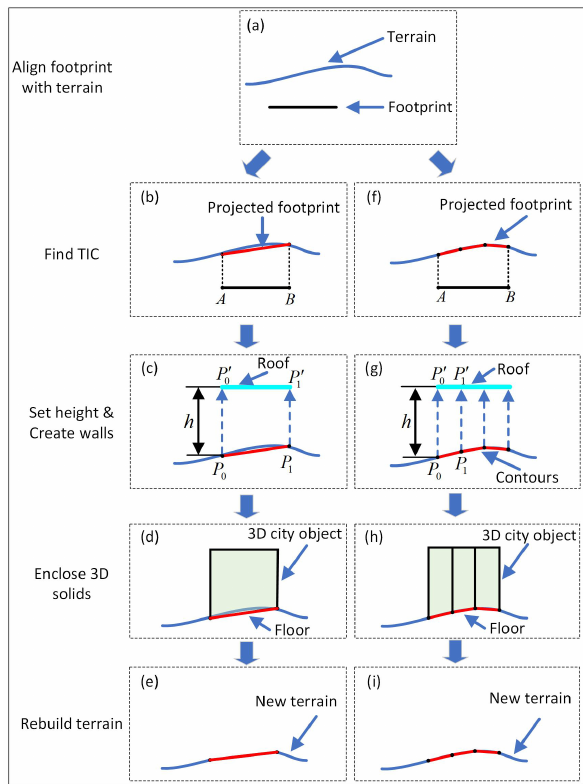
Figure 4. The process of 3D modelling based on footprint and